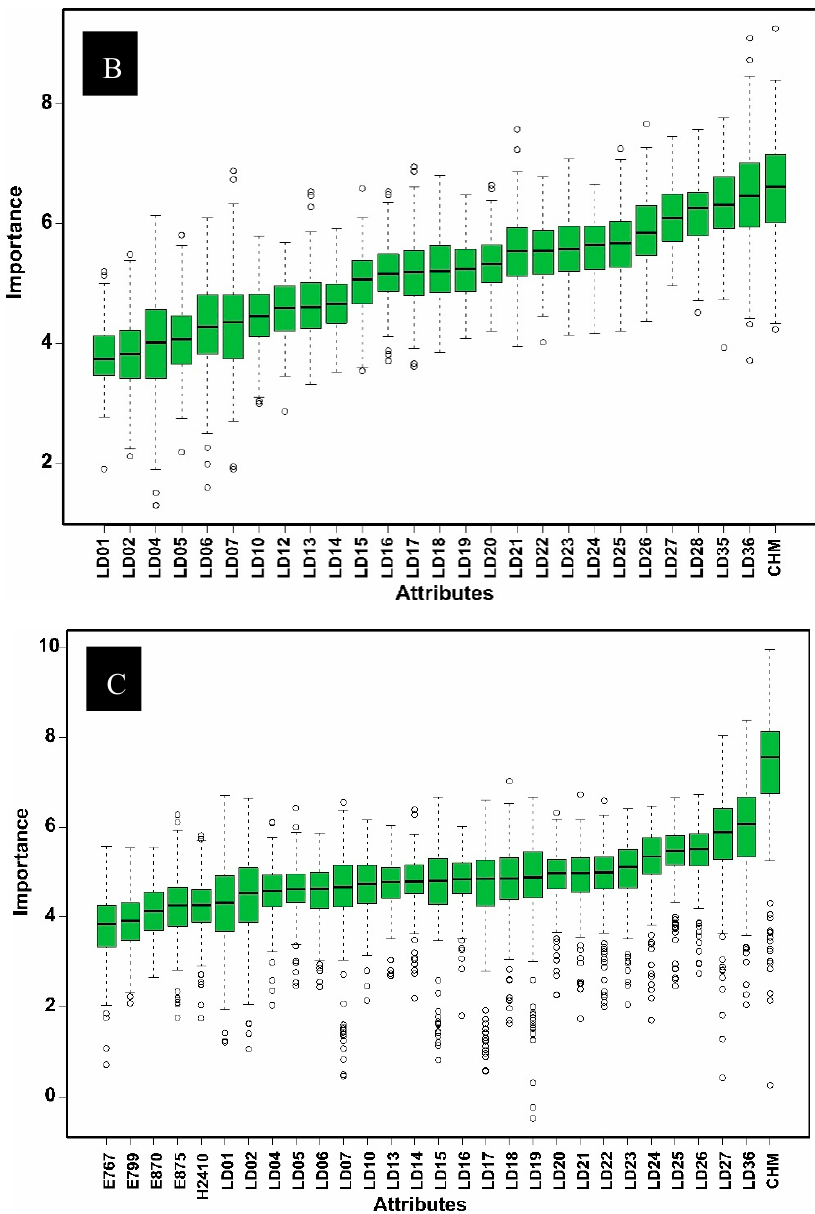
Figure 5. Selected variables by using Boruta. ( A ) Hyperspectral datasets (E 769 , E 804 , H 1924 , and H 2410 ), ( B ) lidar height metrics (LD1, LD2, LD4-LD7, LD10, LD12-LD28, LD35-LD36, and CHM), and ( C ) hyperspectral and lidar metrics (E 767 , E 799 , E 870 , E 875 , H 2410 , LD1, LD2, LD4–LD7, LD10, LD13–LD27, and LD36), based on the number of variables with better performance against the shadow variables ( y -axis; importance).